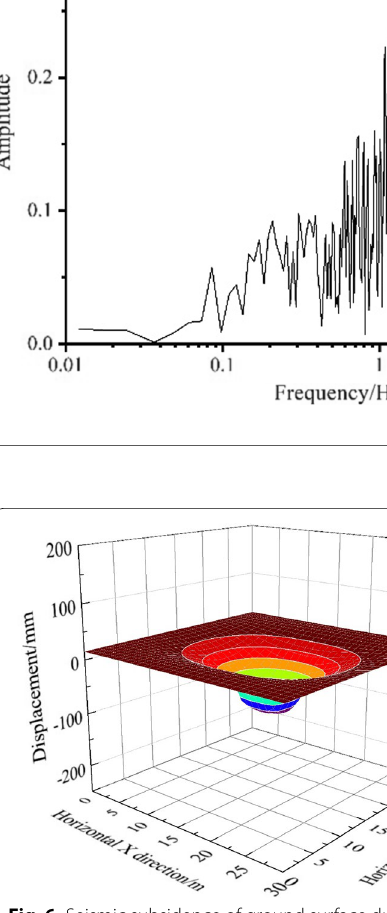
Fig. 6 Seismic subsidence of ground surface due to 0.15 g El Centro ground motion (full